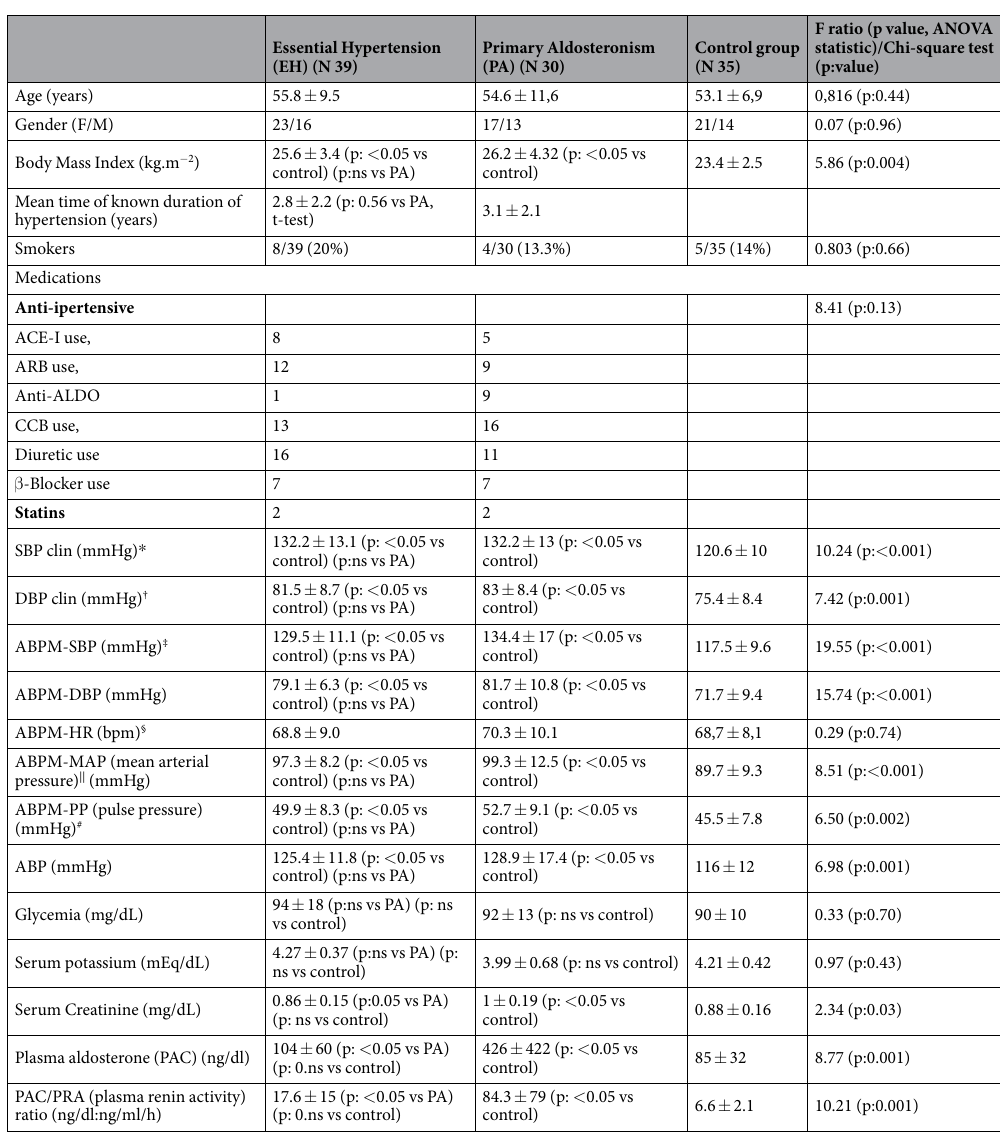
Table 1. Retinal microvascular and systemic macrovascular assessment in hypertension secondary to primary aldosteronism. Demographic characteristics, clinical data and laboratory testing of the study groups. *